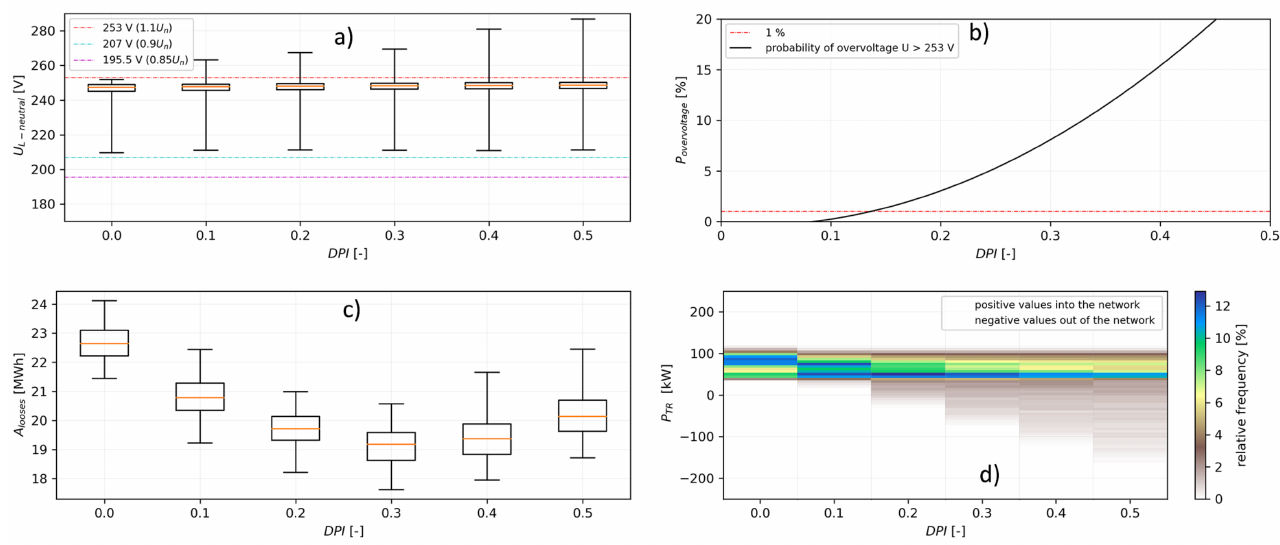
Figure 9. Results of V0 scenario analysis ( a ) box plot of voltage distribution, ( b ) DF of overvoltage, ( c ) box plot of calculated looses distribution, ( d ) heat map of power flow through TR 22/04 power TR.